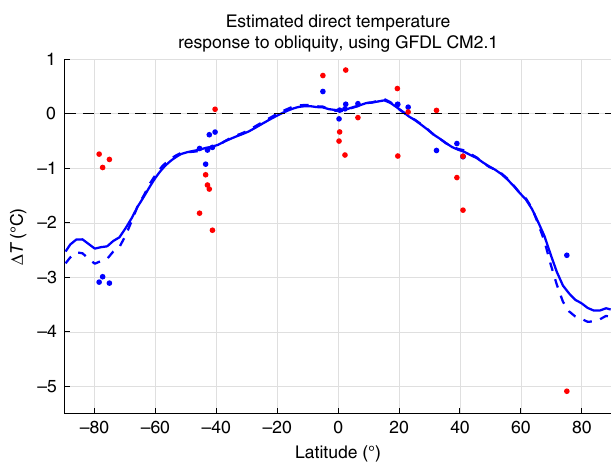
Fig. 3 Obliquity temperature response in GFDL CM2.1 and estimated from proxies. Temperature changes at speci fi c proxy locations in the GFDL CM2.1 low – high obliquity experiment (blue dots) and the apparent direct short-term obliquity response in proxies (red dots), which were derived by scaling the modeled obliquity response in the linear reconstructions to match the proxies. To show how the modeled temperature anomalies at proxy locations compare to zonal-mean values, lines show the zonal-mean anomalies for both surface air temperature (solid) and surface temperature (dashed) in GFDL